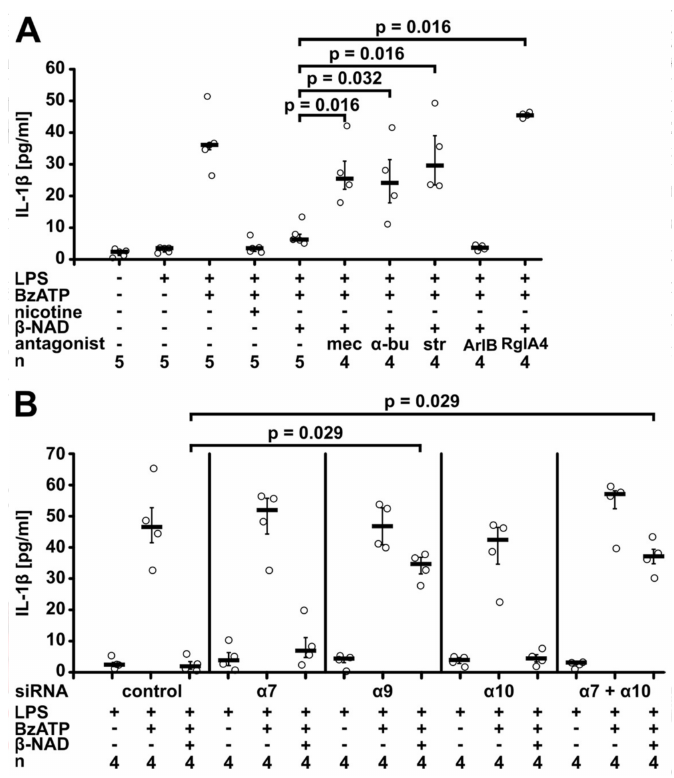
Figure 6. β -NAD signaling involves nicotinic acetylcholine receptors. Human monocytic U937 cells were primed with LPS (1 µ g/mL, 5 h) and activated with 2 (cid:48) (3 (cid:48) )-O-(4-benzoylbenzoyl)adenosine-5 (cid:48) -triphosphate (BzATP; 100 µ M, 30 min). β -NAD was applied together with BzATP at a concentration of 1 mM. The concentration of IL-1 β in the cell culture supernatant was measured by ELISA. ( A ) Nicotinic antagonists mecamylamine (mec; 100 µ M), α -bungarotoxin ( α -bu; 1 µ M), strychnine (str; 10 µ M), and α -conotoxin RgIA4 (200 nM) reversed the inhibitory effect of β -NAD, whereas α -conotoxin ArIB [V11L, V16D] (500 nM) was ineffective; ( B ) U937 cells were transfected with control siRNA or with siRNA targeting nicotinic acetylcholine receptor subunits α 7, α 9, or α 10 ( CHRNA7, CHRNA9, CHRNA10 ). Data are presented as individual data points, bars indicate median, whiskers encompass the 25th to 75th percentile, Kruskal-Wallis test followed by the Mann-Whitney rank sum